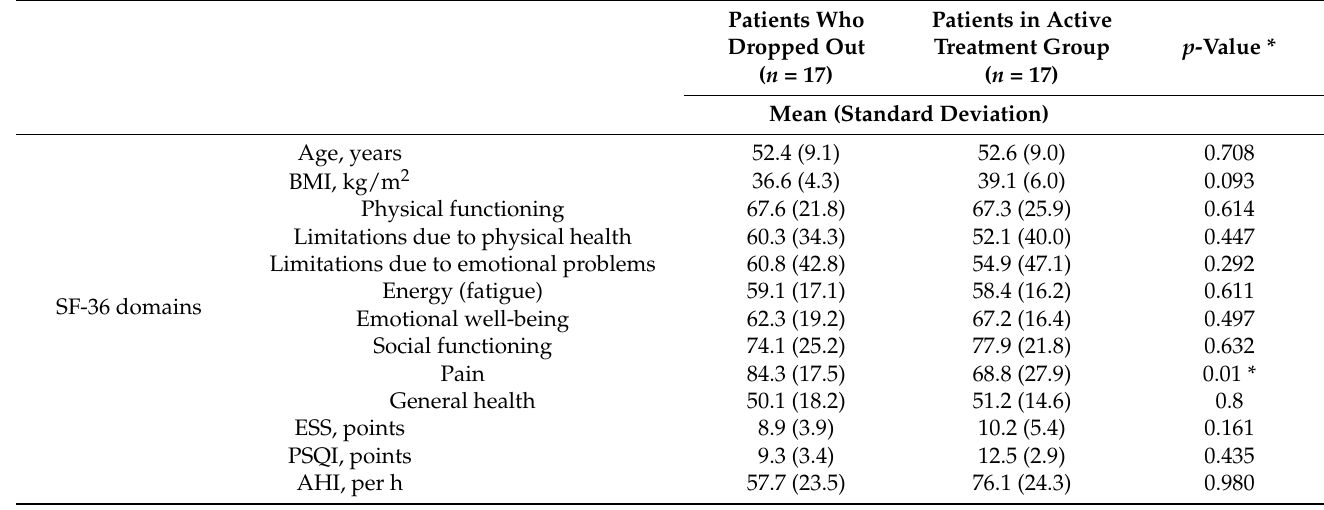
Table 1. Characteristics of patients who dropped out compared with remaining study population.